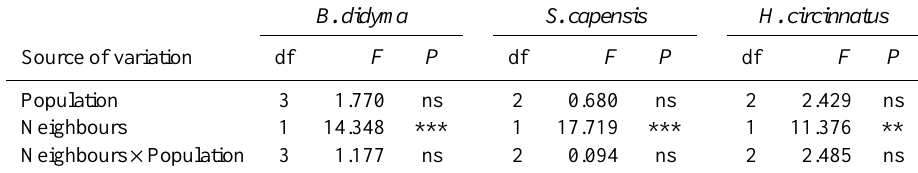
Table 1. Results of repeated-measures ANOVAs testing the e ff ect of population origin and neighbour presence on aboveground biomass at harvest of targets of Biscutella didyma, Stipa capensis and Hymenocarpos circinnatus . ** P < 0 . 01, *** P < 0 . 001. B. didyma